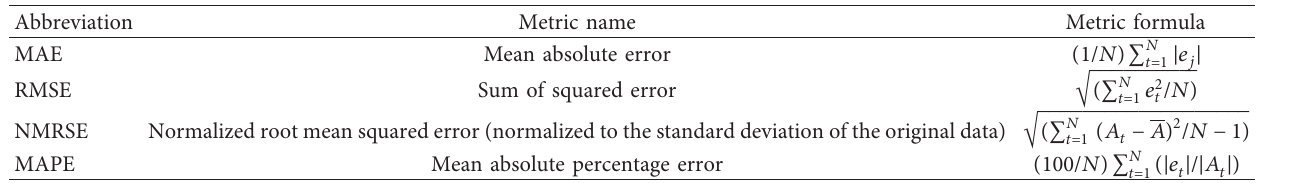
Table 3: Evaluation metrics.